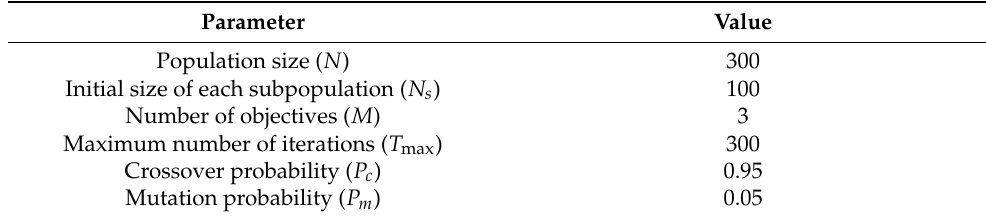
Table 4. Experimental parameter settings for the co-evolutionary NSGA-III (NSGA-III-COE) perfor- mance